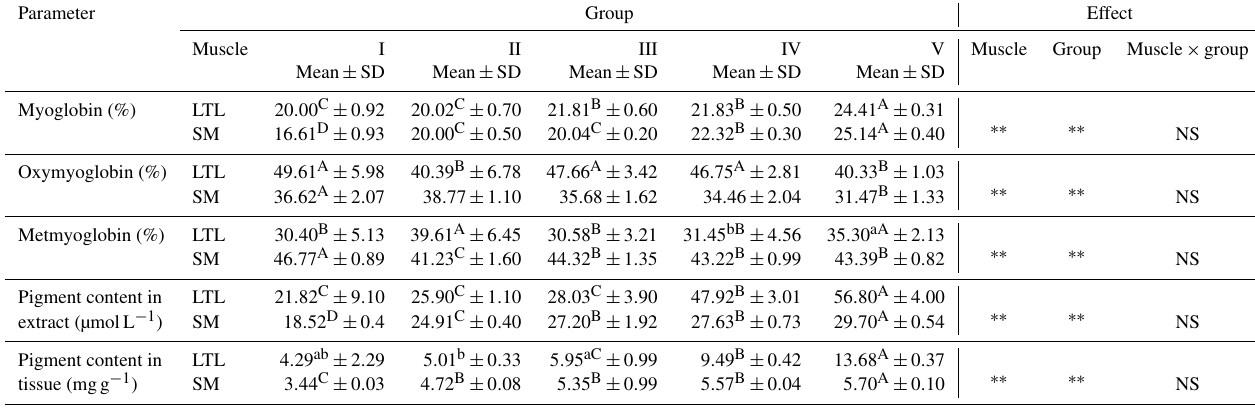
Table 2. Pigment content in meat from female wild boars ( Sus scrofa scrofa L.) of different carcass weights. Parameter